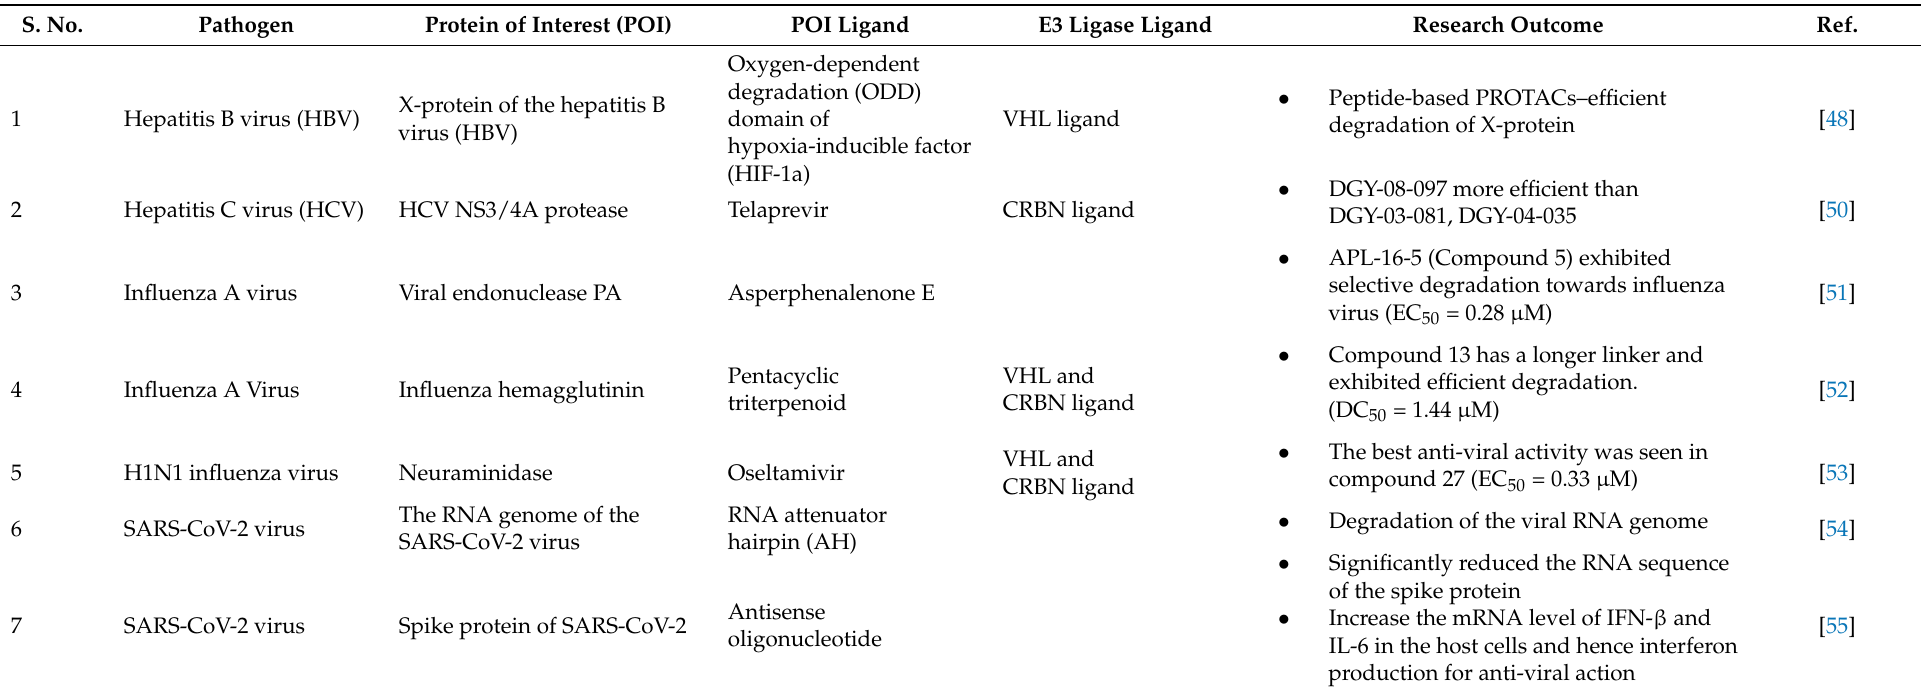
Table 2. Comprehensive information on the targeted degradation of viral protein in the eukaryotic system using PROTAC molecules. S.